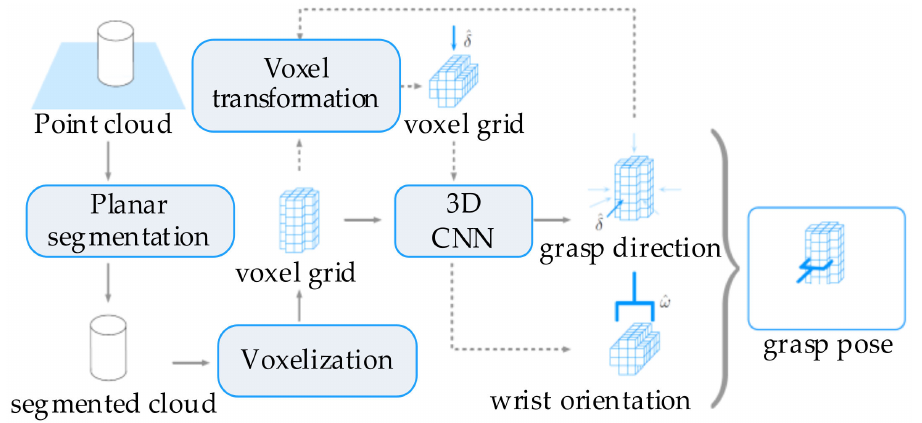
Figure 15. Framework of point cloud processing